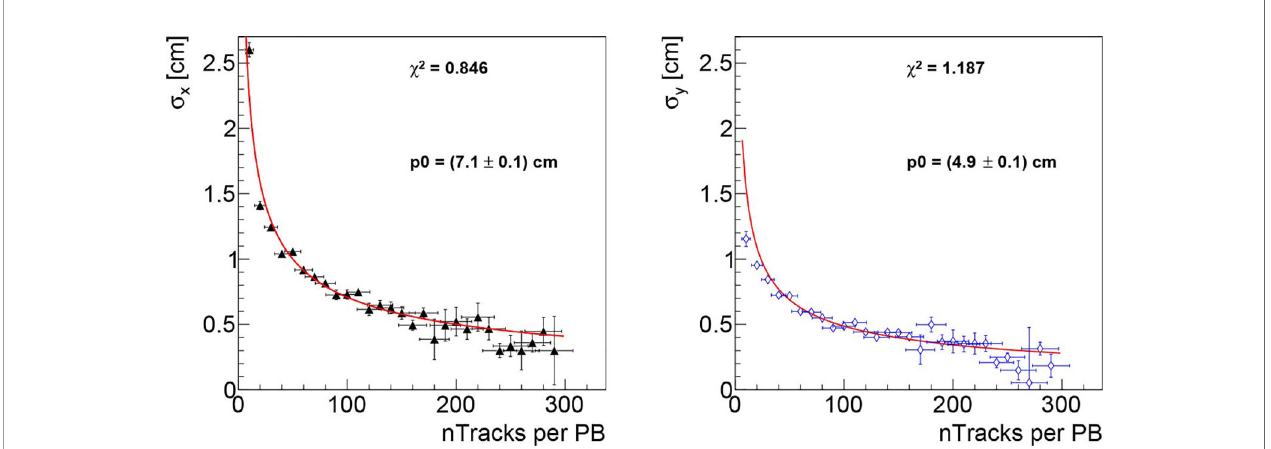
FIGURE 7 | Beam transverse position resolution as a function of the number of reconstructed tracks per PB, respectively for the x (left) and y (right) directions, obtained analysing the data collected in fi rst fraction of PZC. As expected, the resolution scales proportionally to p 0 = red to guide the eye.